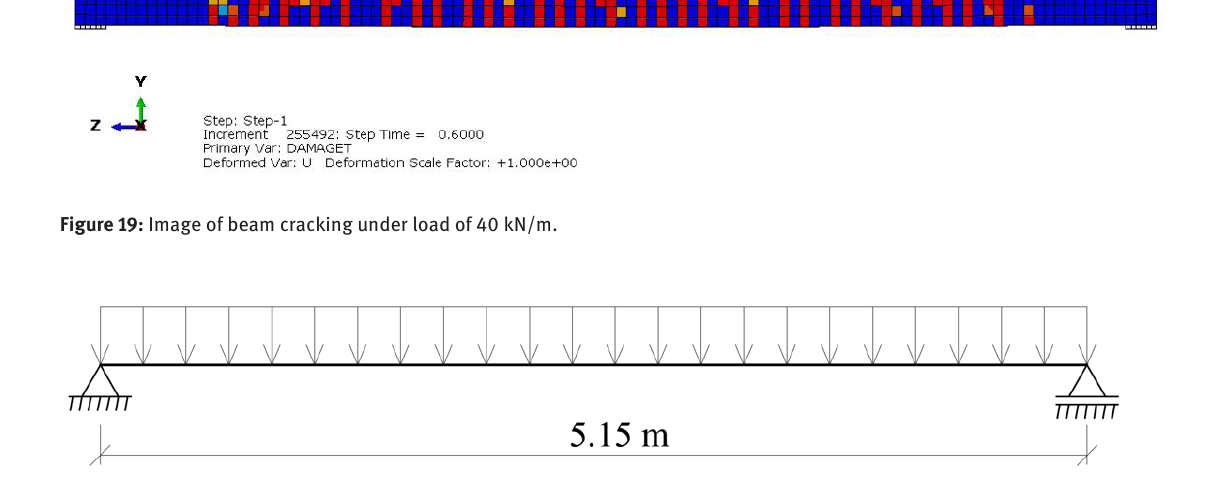
Figure 20: Structure and loading diagram – simply supported beam uniformly loaded along its whole